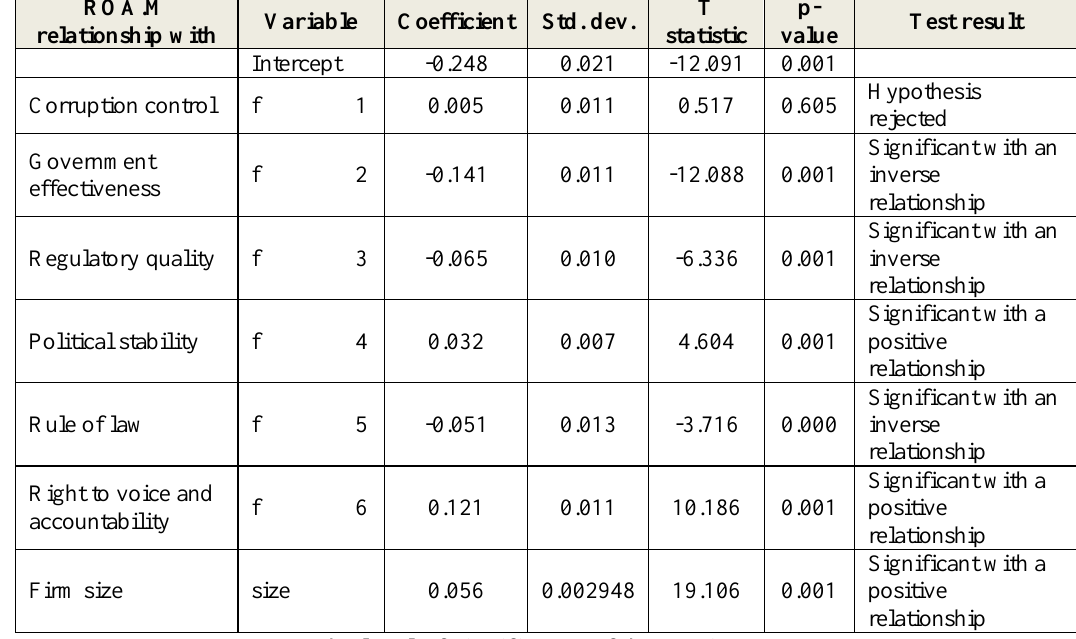
Table 7. ROA.M relationship with governance